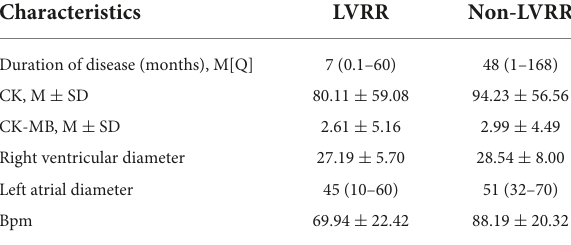
TABLE 3 Comparison of important features obtained by greedy